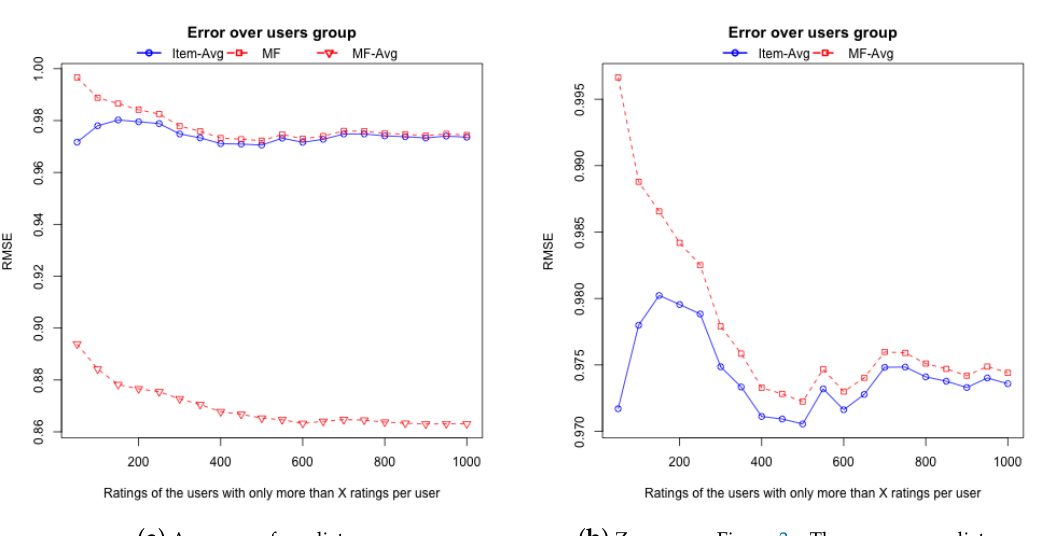
Figure 3. Prediction techniques and average comparisons regarding the